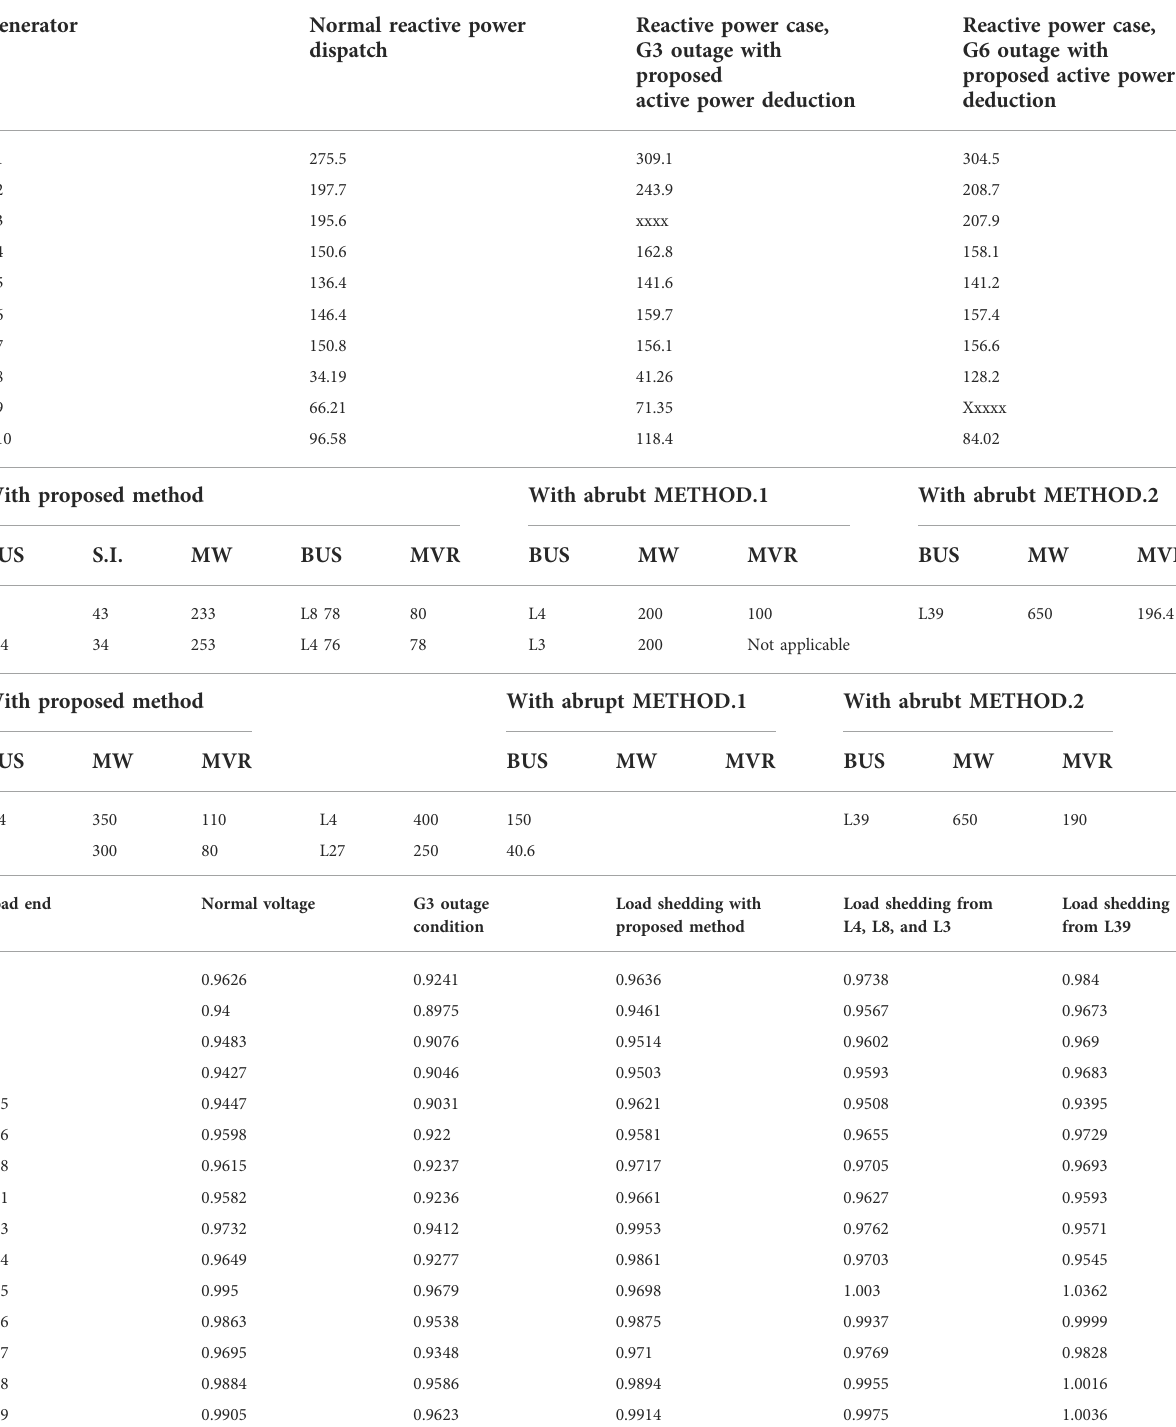
TABLE 3 (A) Reactive power delivery by generators in case of generator outage and with active power deduction. (B) Active and reactive power deduction in case of G 3 Outage. (C) Active and reactive power deduction in a different way in G6 outage. (D) Load voltage in G 3 outage